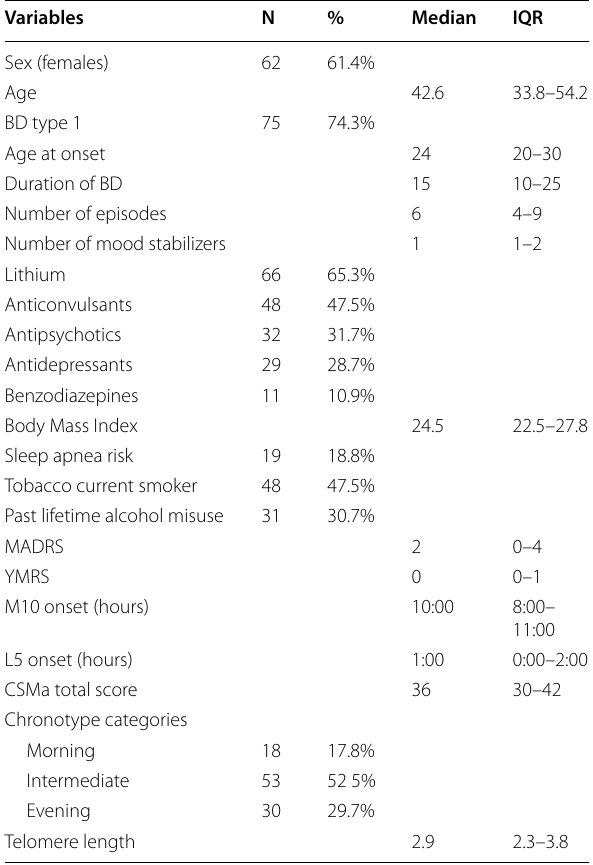
Table 1 Socio‑demographic and clinical characteristics of the